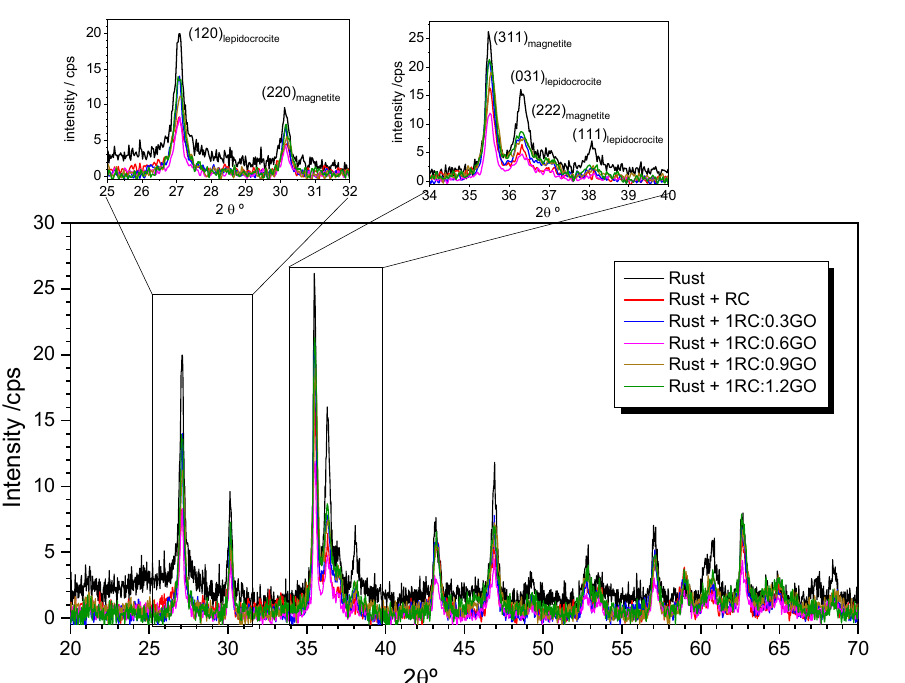
Figure 5. X-ray diffractograms obtained for rust powder and the different RC/GO mixtures tested, after being in contact for 15 days.